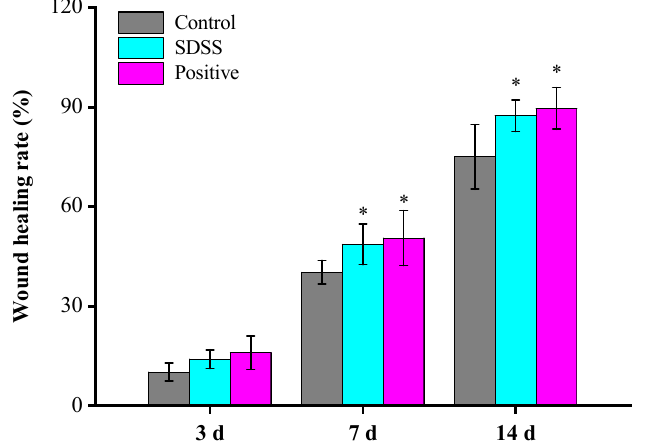
Figure 2. The wound-healing rate of mice ( n = 5). * p < 0.05 in comparison to the control group.